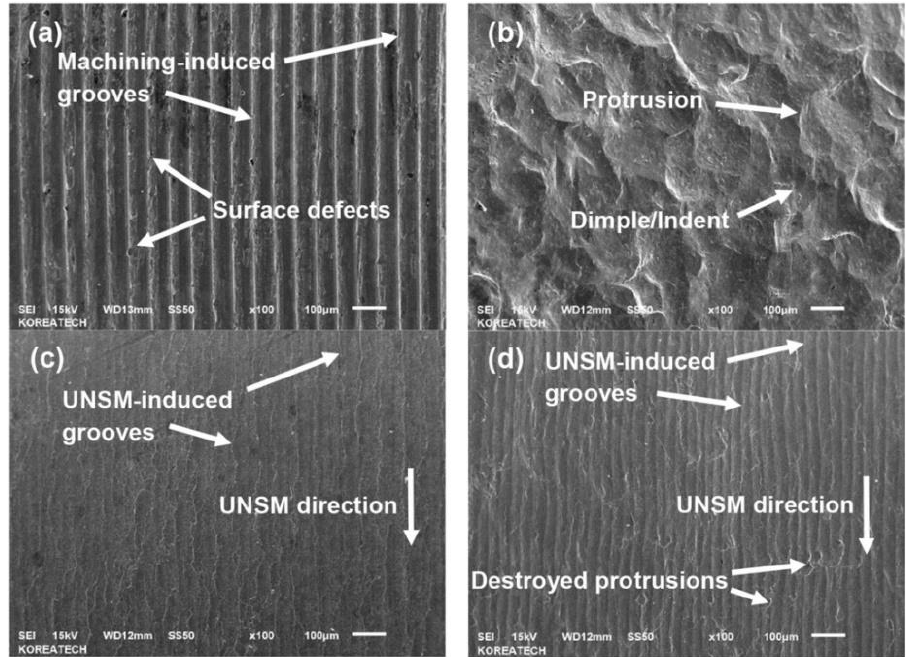
Figure 8. Scanning electron microscopy (SEM) images of the surface conditions of AISI 4340 speci- mens in ( a ) as-received condition and after ( b ) SP, ( c ) UNSM, and ( d ) SP + UNSM treatments. Reprinted with permission from Ref. [28]. Copyright 2020 Elsevier.